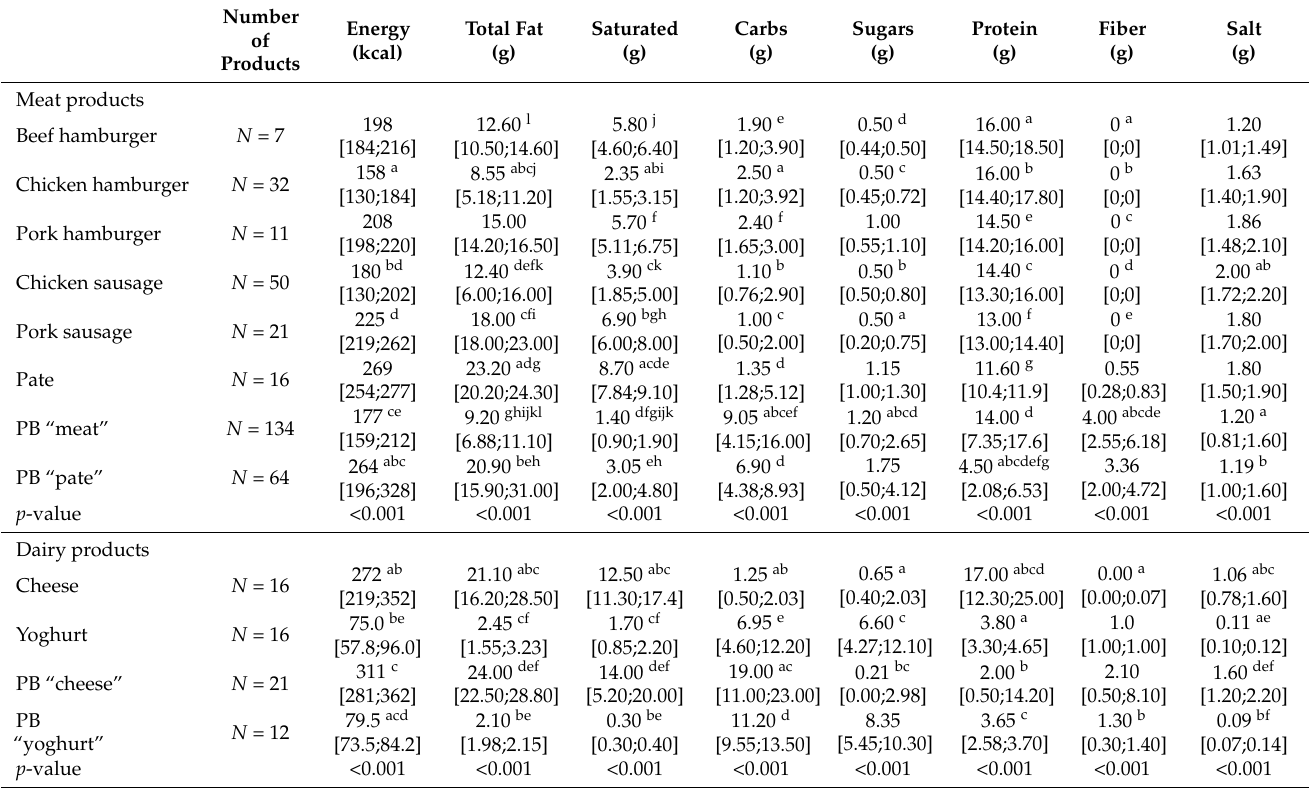
Table 2. Nutrient composition from the pack labelling by foods, per 100 g of AB foods and PB